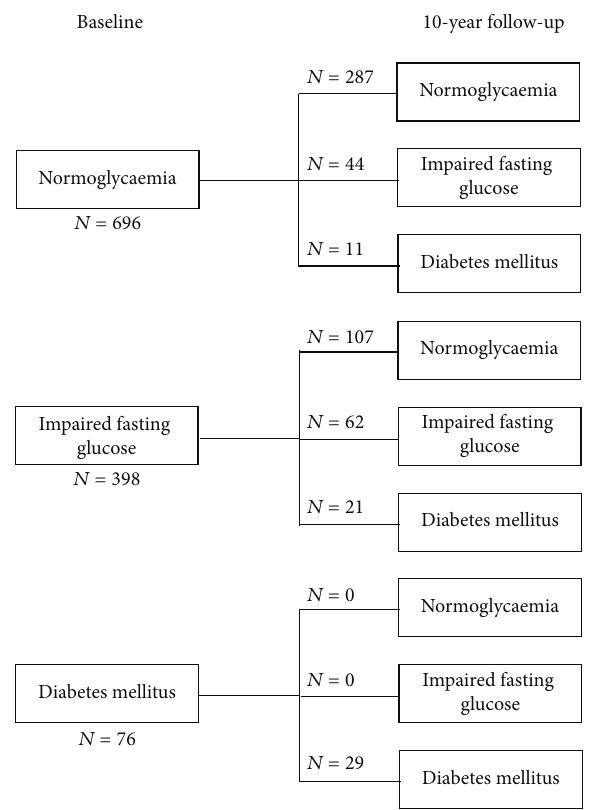
Figure 2: Numbers of women in each of the three glycaemia groups who became normoglycaemic and developed impaired fasting glucose or diabetes over the 10-year follow-up. Note: missing data for 354 women with normoglycaemia at baseline, 208 women with impaired fasting glucose at baseline, and 47 women with diabetes at